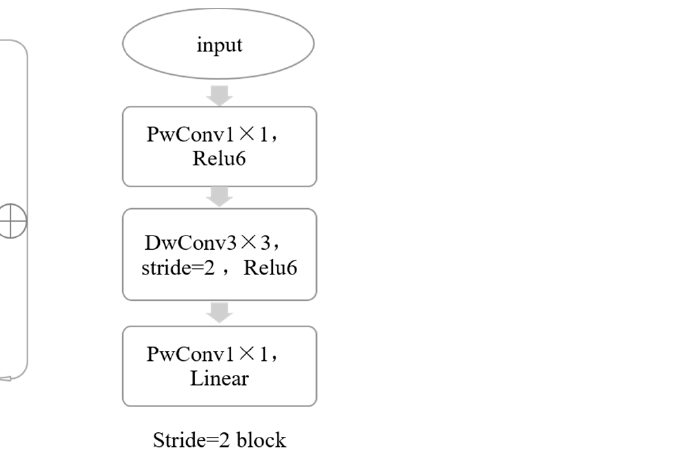
Figure 3. MobileNetV2 network architecture.